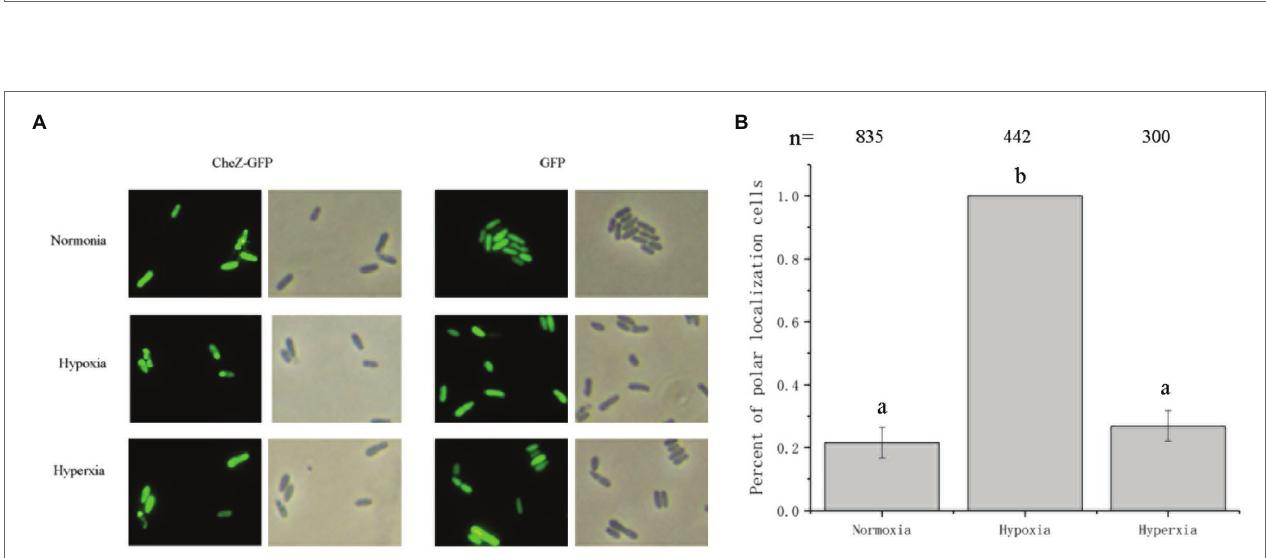
FIGURE 2 | Localization of CheZ with different oxygen concentrations. (A) Representative images of localization of CheZ under normoxia, hypoxia, or hyperxia conditions after culturing for 12 h with shaking. (B) Quantification of the ratio of cells with polar localization of CheZ under normoxia, hypoxia, or hyperxia conditions. The values are shown as the means ± SDs from at least three independent experiments. The same letter above the bars indicates no significant difference at p < 0.01, one-way ANOVA with Tukey’s multiple-comparison